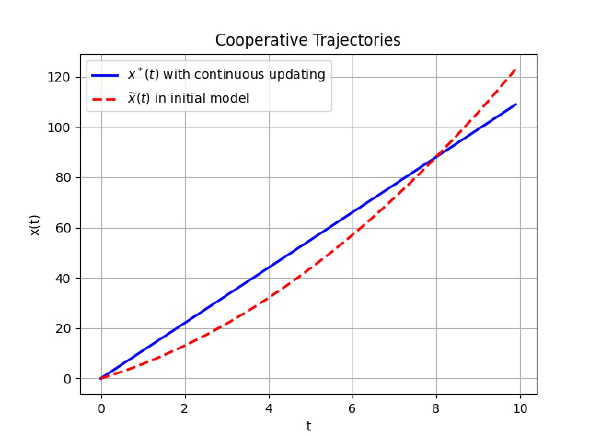
Figure 2. Cooperative trajectory in the initial game (cid:101) x ( t ) (red line) and cooperative trajectory with continuous updating x ∗ ( t ) (blue